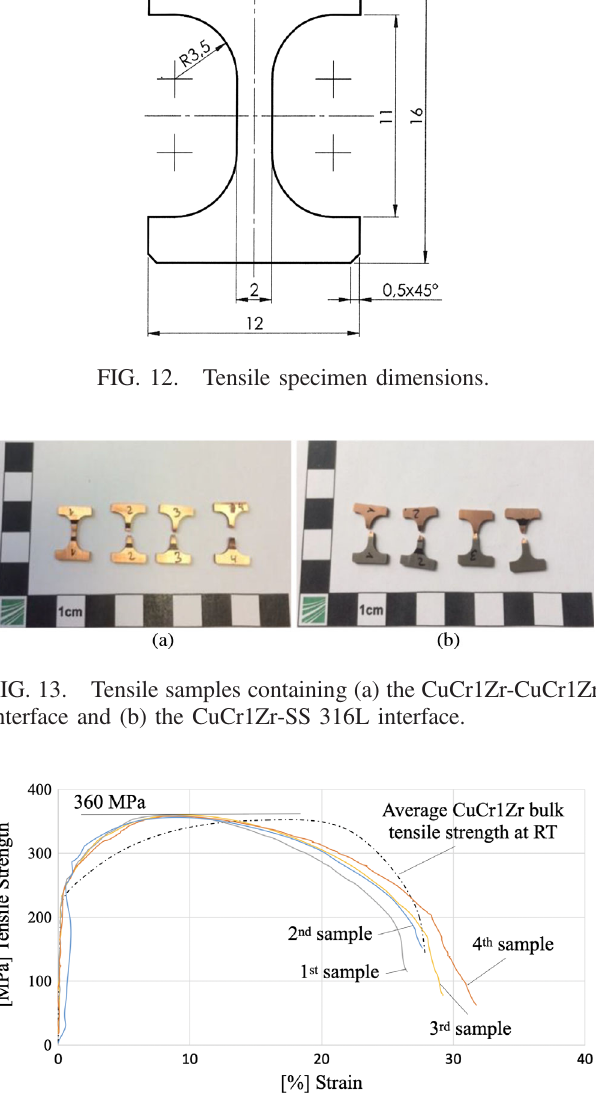
FIG. 14. Room temperature tensile stress-strain curves for CuCr1Zr-SS 316L specimens and bulk hardened CuC1Zr as a reference.